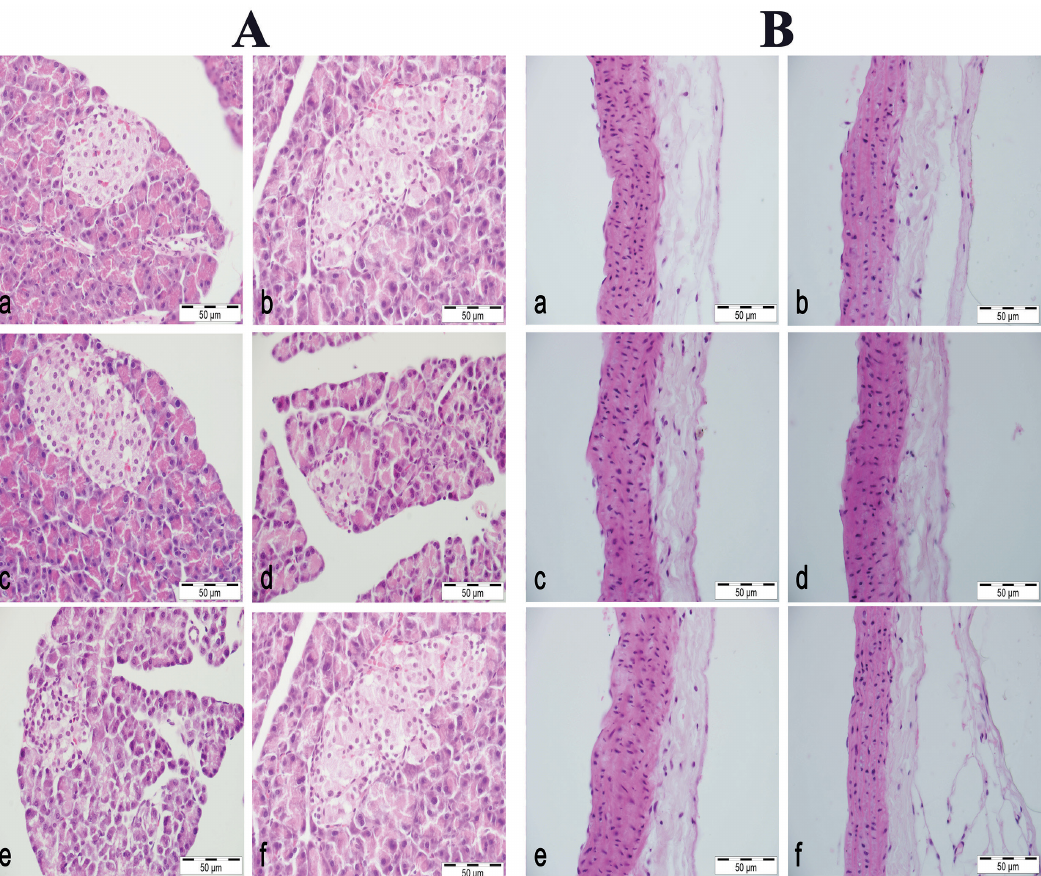
FIGURE 1 - A: Pancreas a) Normoglycemic Control group: Normal pancreas histomorphology, b) Diabetes control group: Significant amount of hydropic degeneration in the islet of Langerhans with some necrosis, c-e) Diabetes + Extract groups; 500, 1000 and 1500 mg, respectively: Some hydropic degeneration in the islet of Langerhans, and f) Metformin group: Weak degeneration. B: Thoracic aorta a) Normoglycemic Control group: Normal aorta histomorphology, b) Diabetes control group: No evident histopathological changes, c-e) Diabetes + Extract groups; 500, 1000 and 1500 mg, respectively: No histopathological changes and f) Metformin group: No